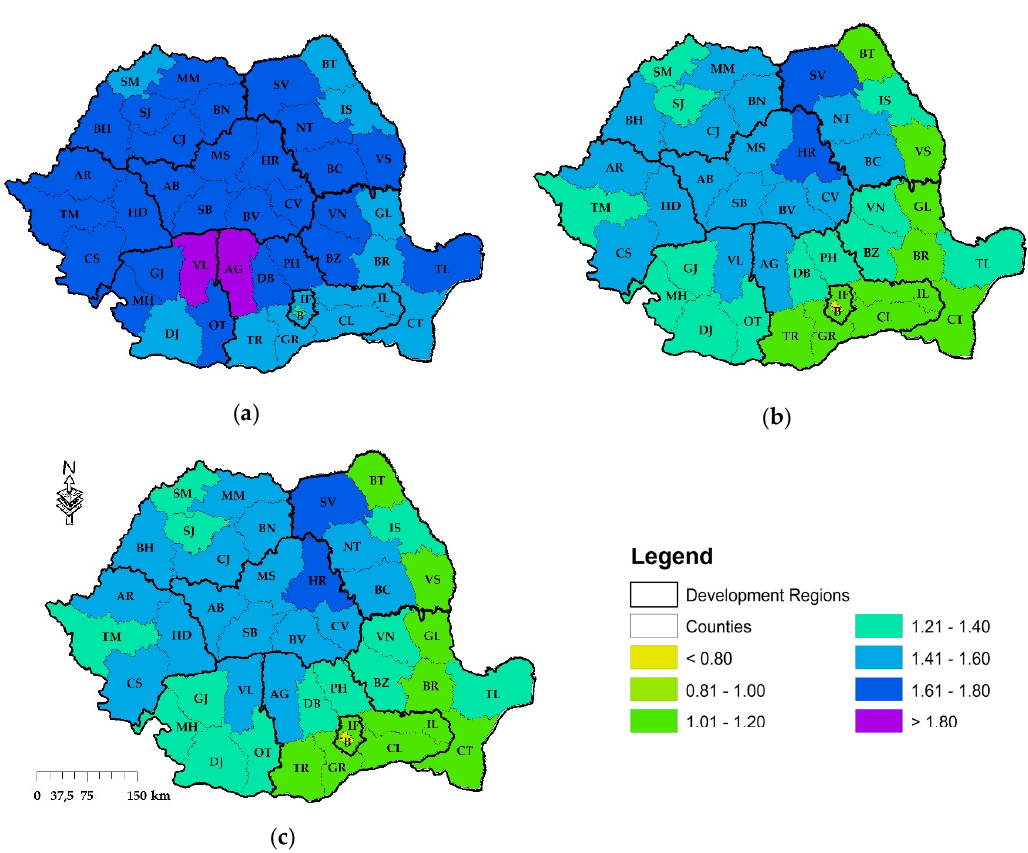
Figure 8. ( a ) The fractal box ‐ counting dimension (D Surf ‐ dil3 ) of forested areas. ( b ) The fractal box ‐ counting dimension (D Surf ‐ dil3 ) of deforested areas. ( c ) The fractal box ‐ counting dimension (D Surf ‐ dil3 ) of reforested areas.